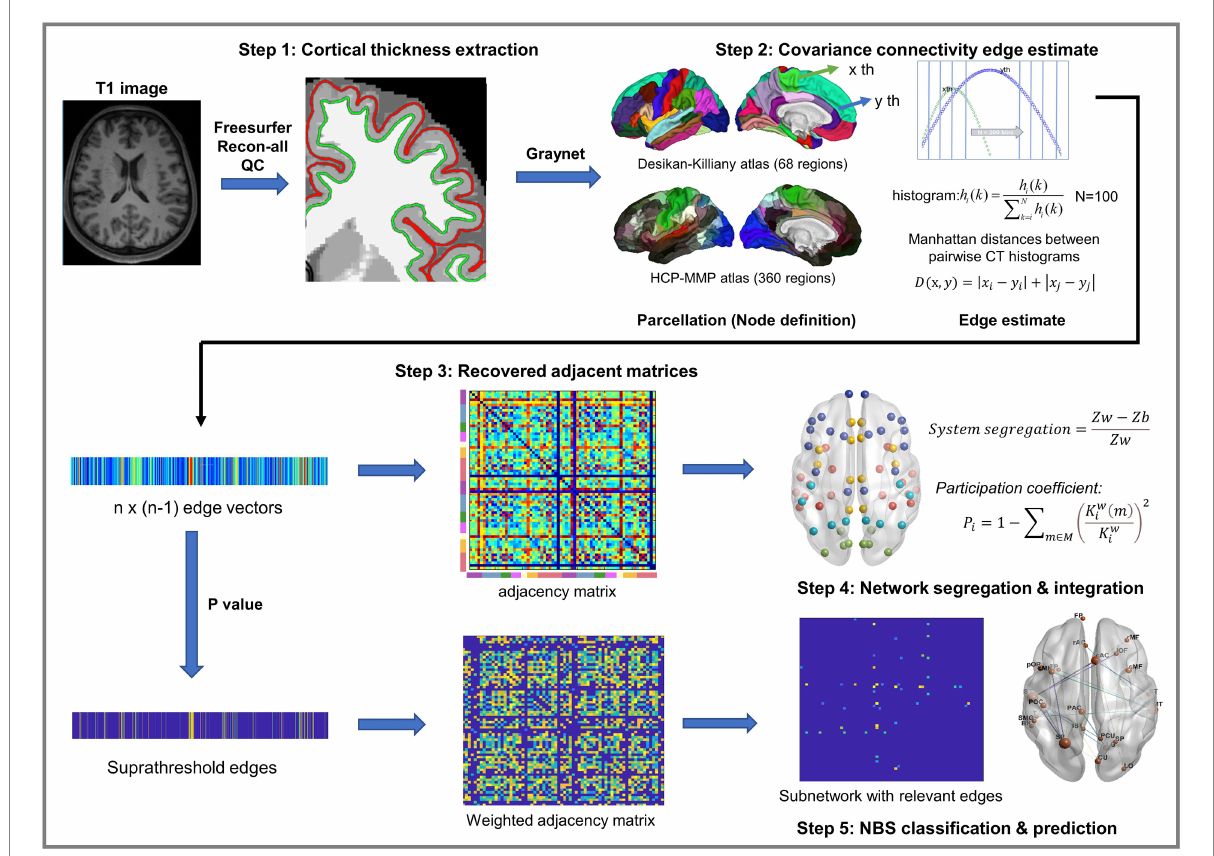
FIGURE 1 Schematic overview. Step 1: T1 anatomical image reconstruction and cortical thickness extraction. Step 2: Single-subject cortical thickness connectivity was constructed using the Graynet software. Step 3: Connectivity edges were computed as vectors, and then recovered into adjacent matrices for group statistics. Step 4: Network segregation and integration calculation. Step 5: Suprathreshold edges were used for further network-based statistics classification and